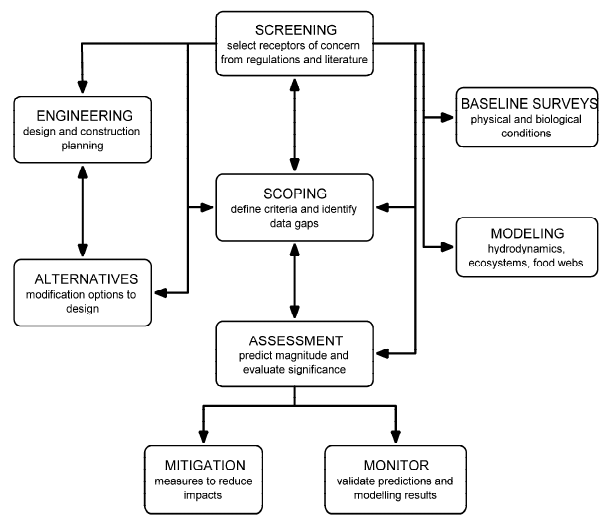
Figure 1. Classic Environmental Impact Assessment (EIA) Workflow Chart. Based upon a summary of Glasson [3], Wathern [4], and Petts [7].